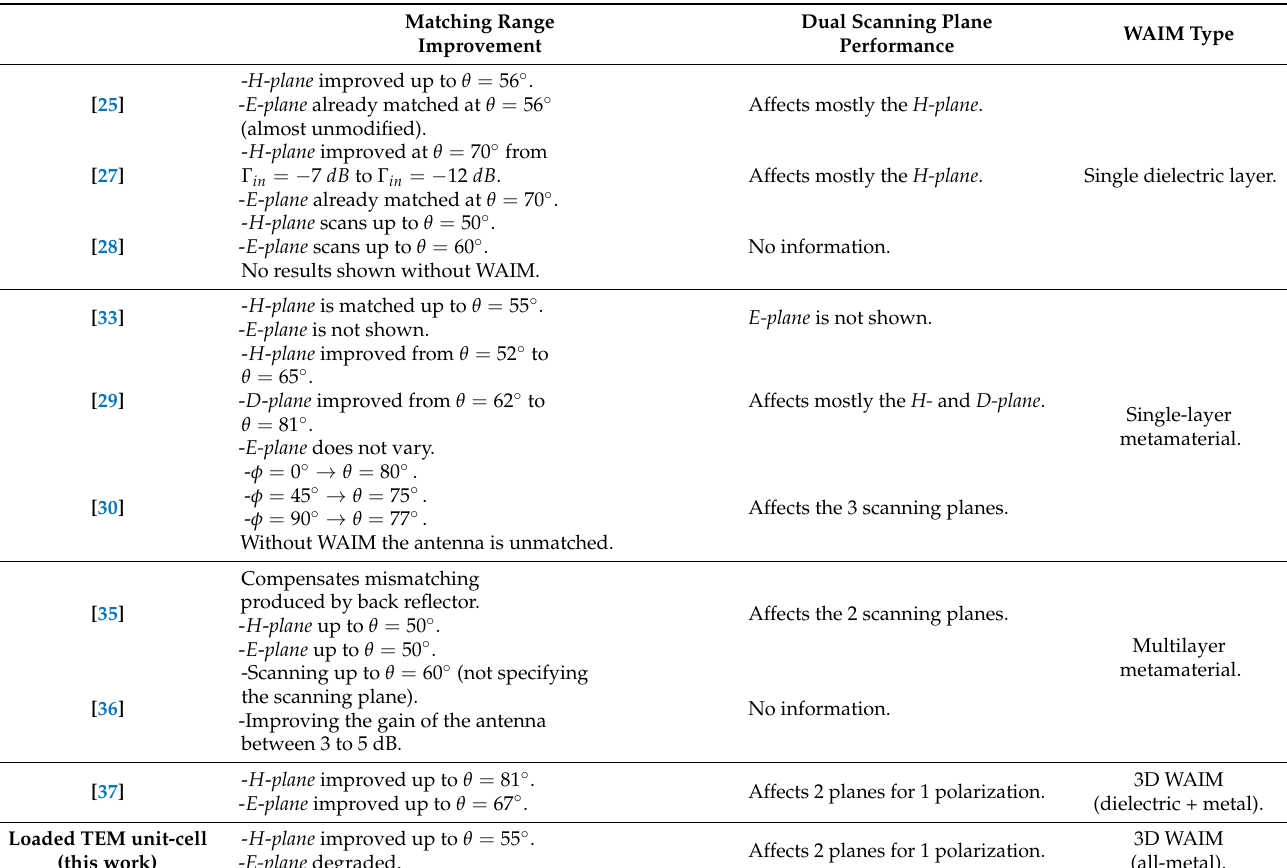
Table 1. Comparison of the proposed design with the